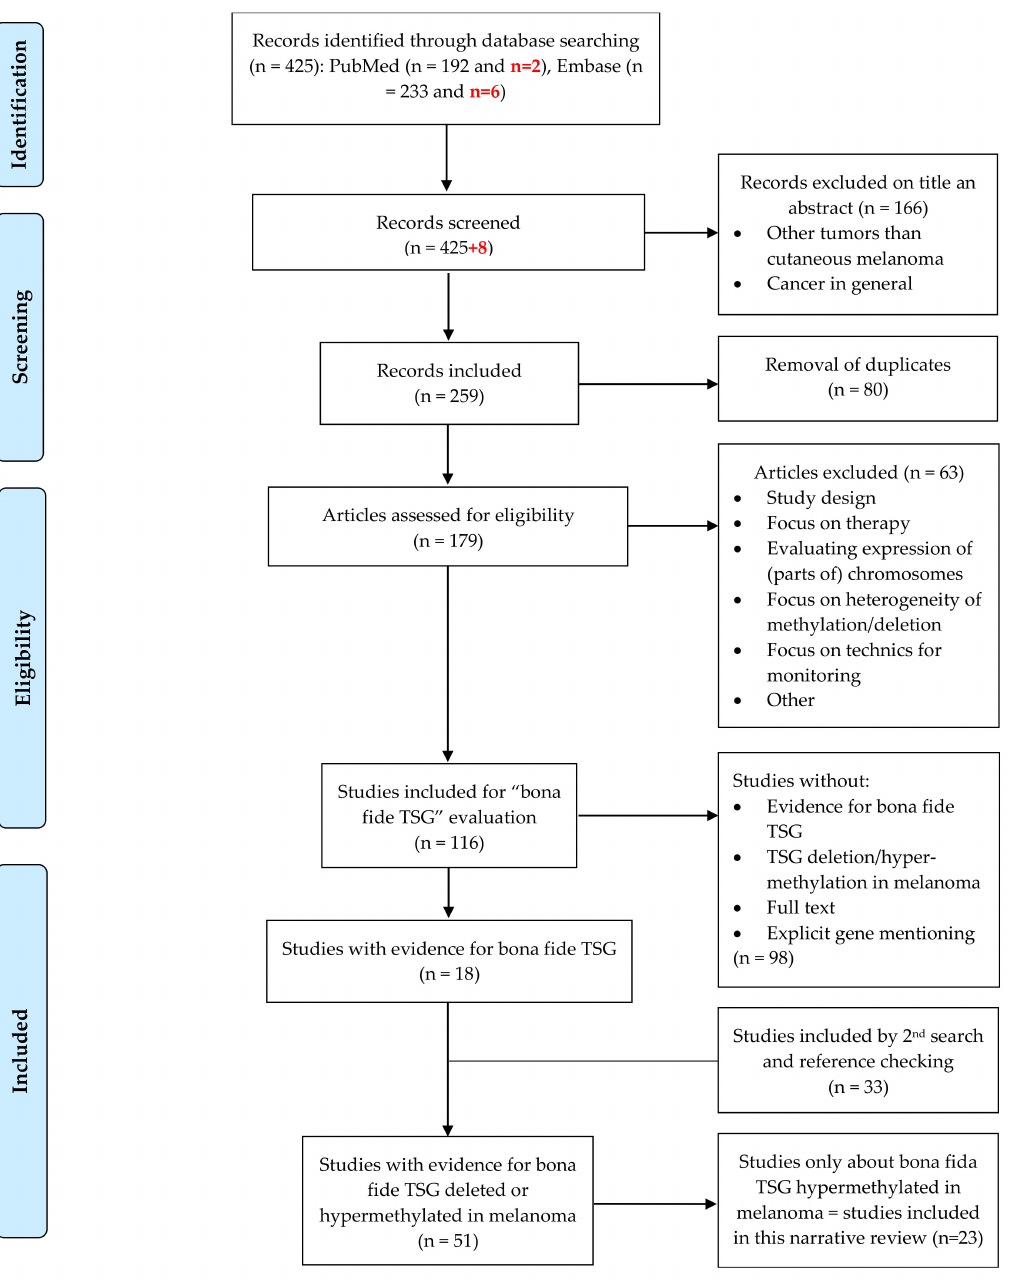
Figure 1. Flowchart of the study selection process. Adapted from: Moher D., Liberati A., Tetzlaff J., Altman D.G., The PRISMA Group (2009). Preferred Reporting Items for Systematic Reviews and Meta-Analyses: The PRISMA Statement. PLoS Med 6(6): e1000097. doi:10.1371/journal.pmed1000097. The marked numbers in bold and in red are the updated search